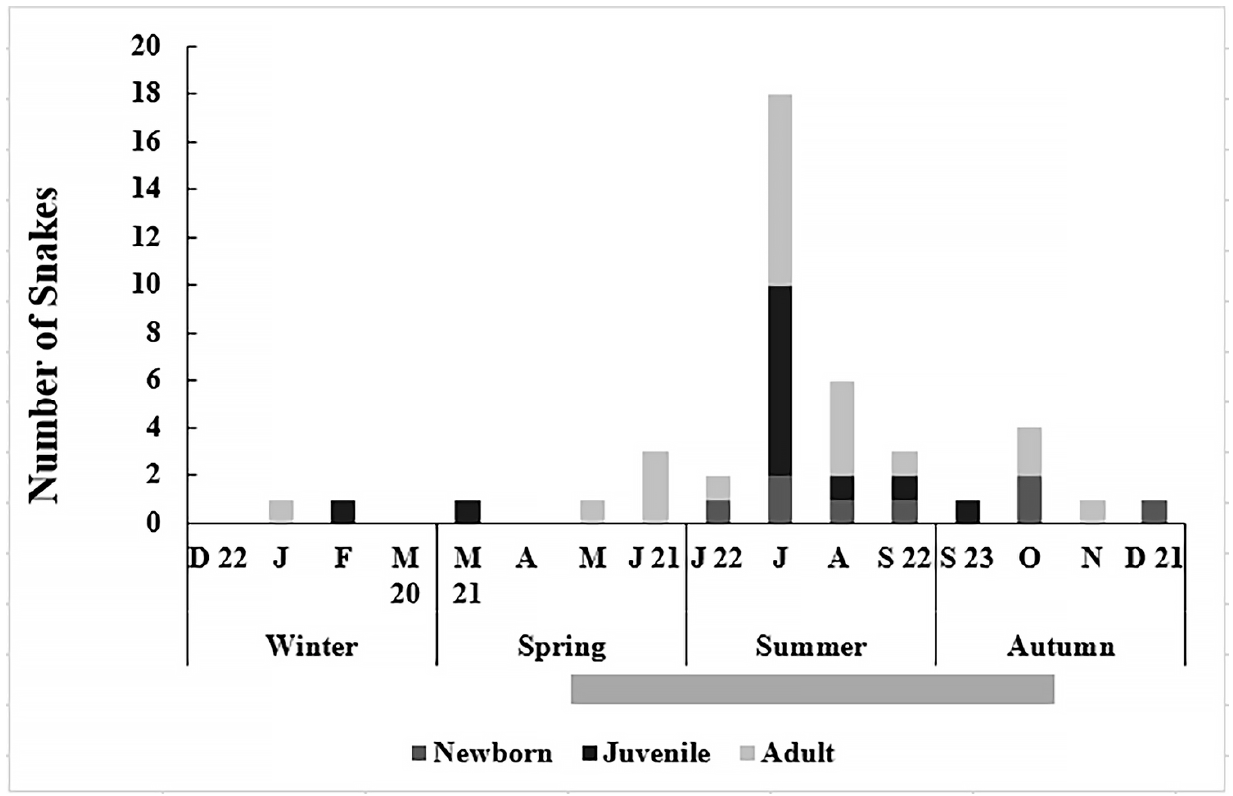
Figure 4. Number of newborns, juveniles, and adults of Tehuantepec Isthmus rattlesnake ( Crotalus ehecatl ) analyzed during this study, by month and season of the year, based on the equinoctial and solstitial periods in the Northern Hemisphere: Spring (21 March to 21 June), Summer (22 June to 22 September), Autumn (23 September to 21 December), and Winter (22 December to 20 March). Gray bar below X axis indicates the rainy season (May–October).